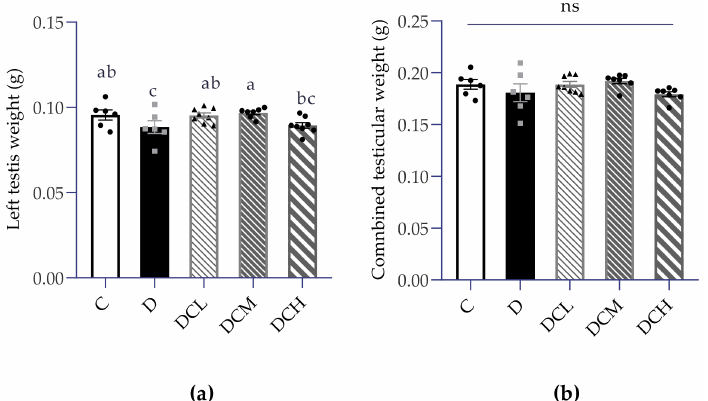
Figure 4. Absolute weight of male reproductive organs (ns, non-significant; Control, C; DSS-treated mice, D; DSS-C3G (12.5 mg/kg), DCL; DSS-C3G (25 mg/kg), DCM; DSS-C3G (50 mg/kg), DCH). ( a ) Left testis weight, n = 7–8. ( b ) Combined testicular weight, n = 6–8. (cid:78) • (cid:4) : The number of symbols was consistent with the number of samples, and the relative position represented the degree of data dispersion. Results are shown as mean ± SEM. Parameters marked by the same alphabet are not significantly different. Significance is expressed as p <